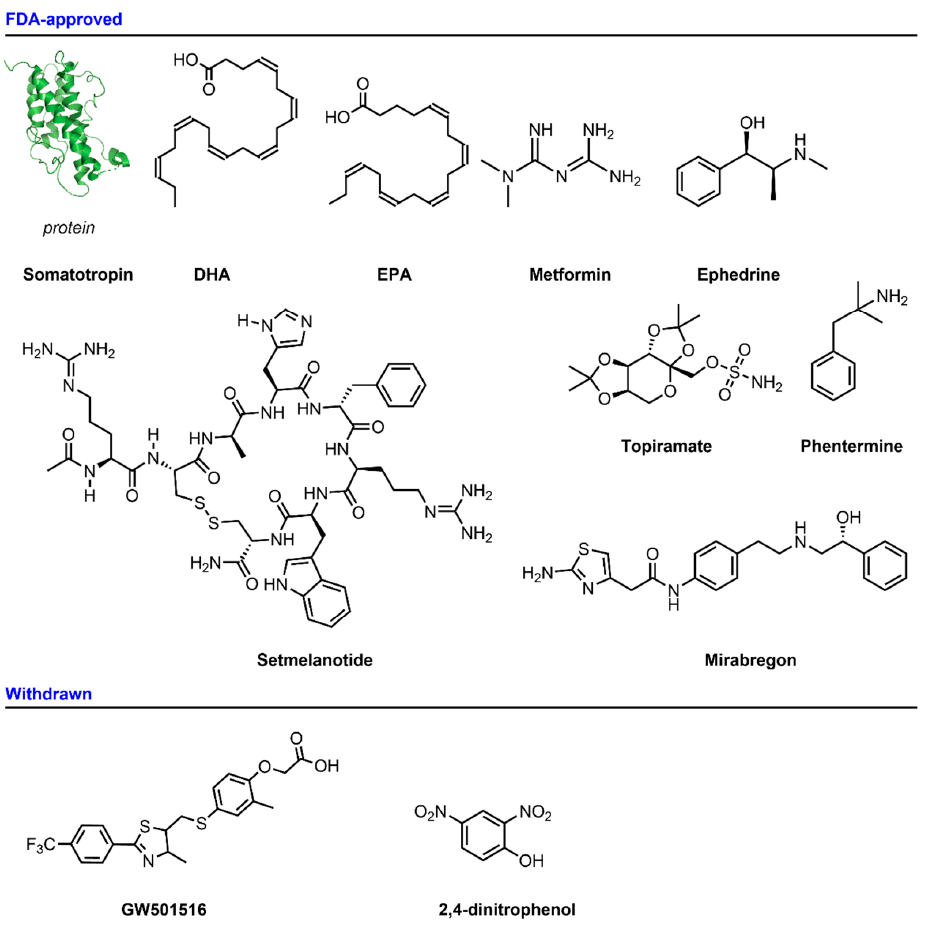
Figure 3. Chemical structures of drugs that increase energy expenditure that are approved by the FDA and withdrawn from the market.